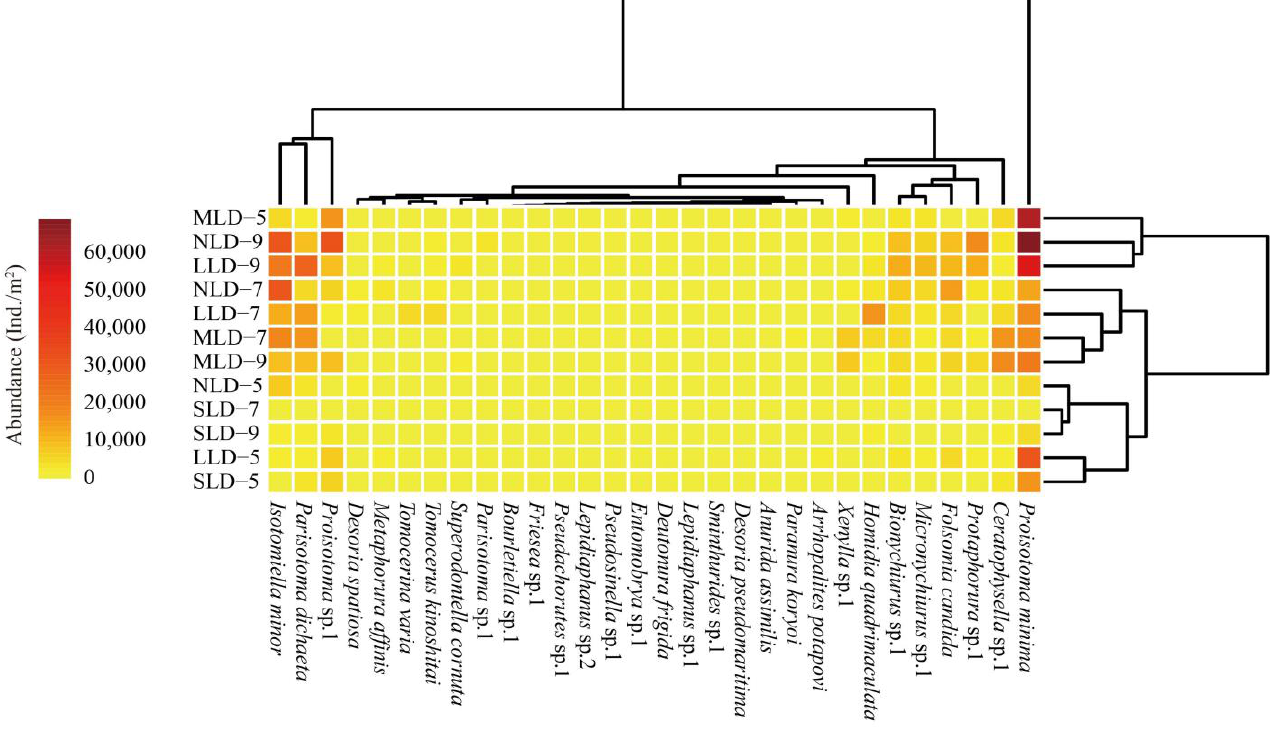
Figure 4. Abundance heatmap of log(x + 1)-normalized soil Collembolans in different land- degradation habitats. Dendrogram of sample sites based on similarity along right axis; dendrogram of soil Collembolan species based on similarity along upper axis. Colors represent abundance of soil Collembolans. Five indicate spring; seven indicate summer; nine indicate autumn. NLD, no land- degradation habitat; LLD, light land-degradation habitat; MLD, moderate land-degradation habitat; SLD, severe land-degradation habitat.